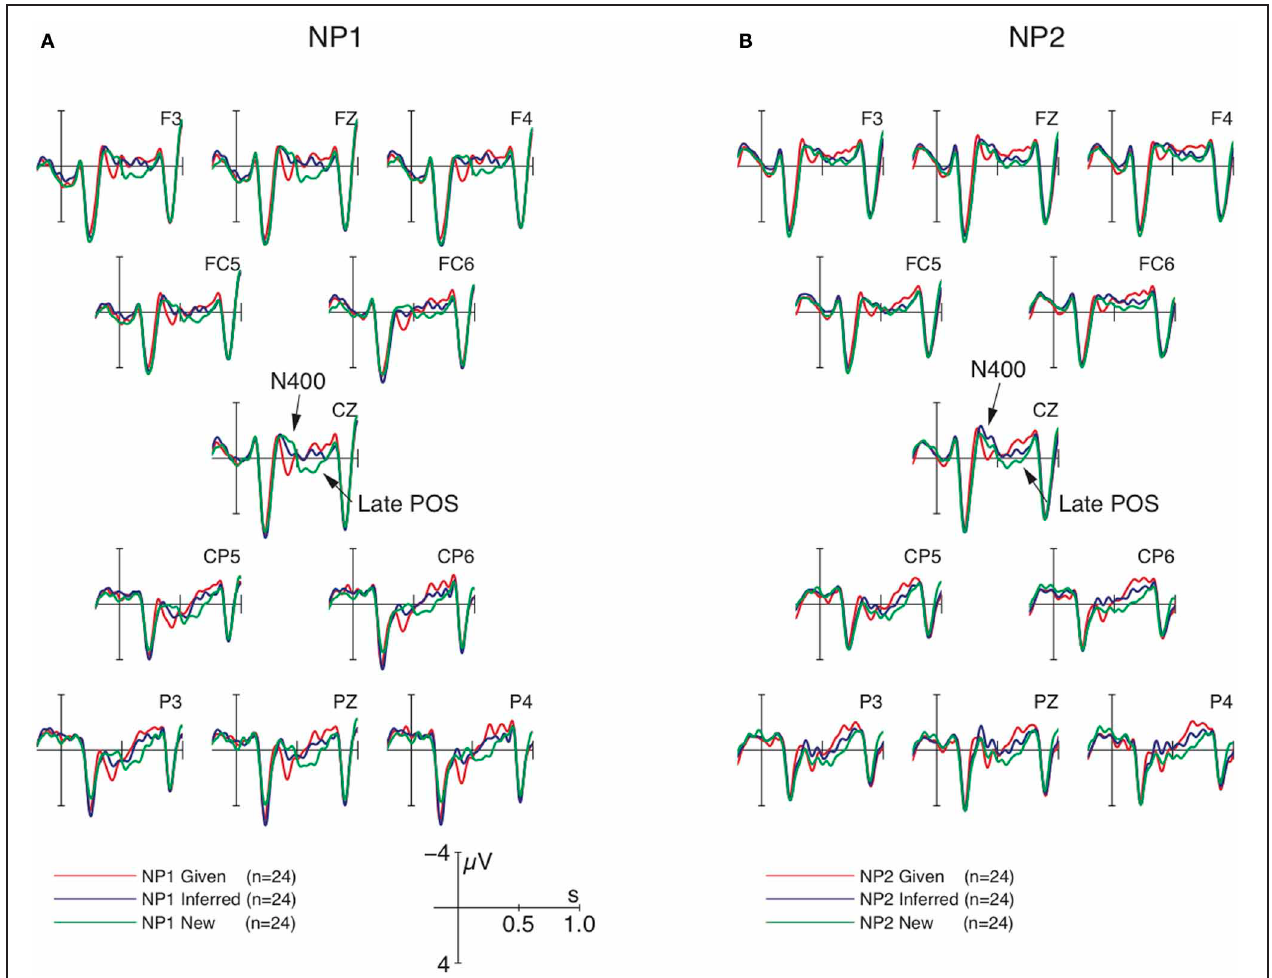
FIGURE 2 | Grand average ERPs ( n = 24) time-locked to the dative NP (onset at the vertical bar) in the Given, Inferred, Contrastive New contexts of Experiment 1. Comparisons of NP1 vs. NP2 are shown in Panels (A) and (B) , respectively. Negativity is plotted upwards.